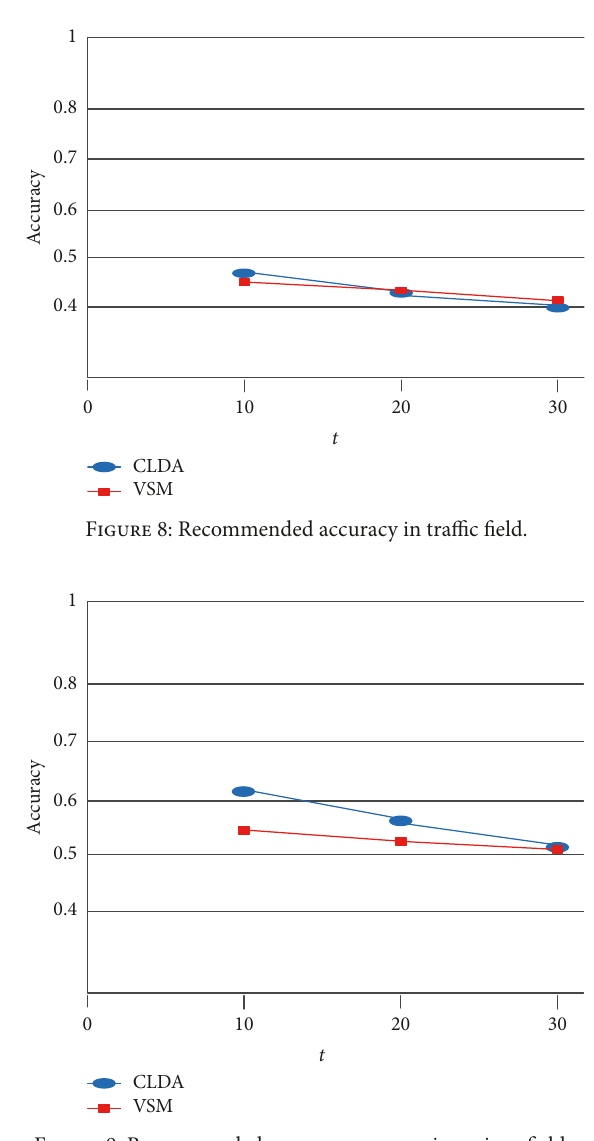
Figure 9: Recommended accuracy averages in various